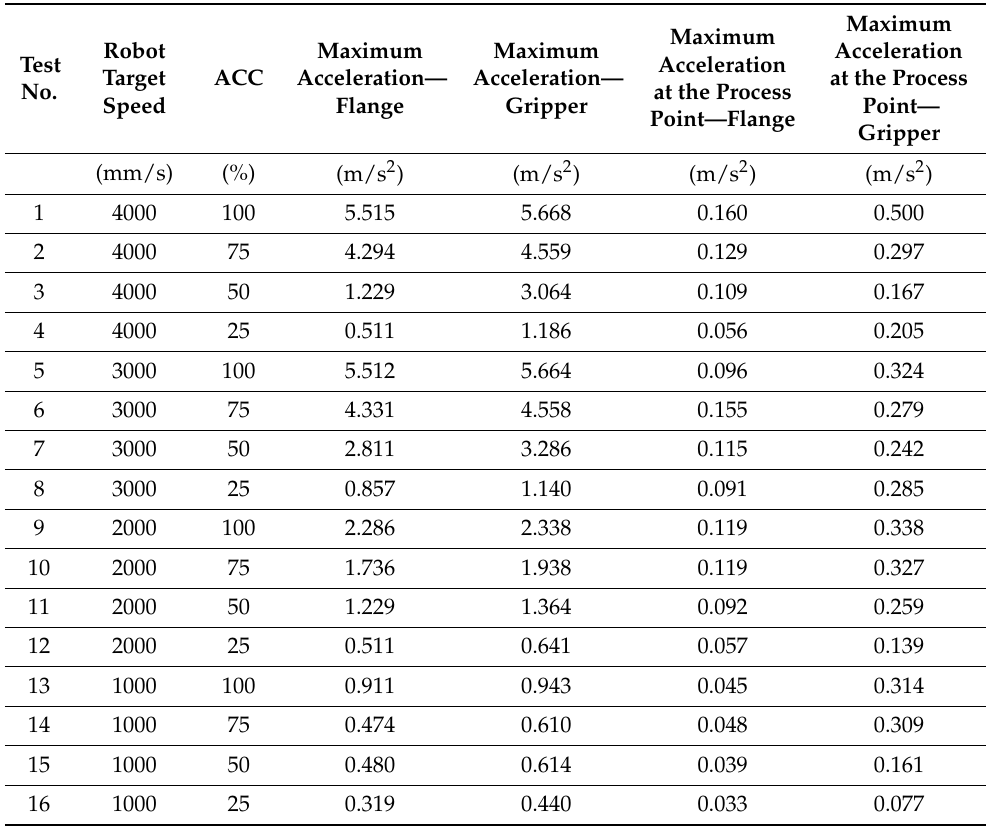
Figure 16. Graphs of accelerations obtained with MTi XSENS sensors mounted at the robot flange and on the gripper for parameters V4000 and ACC100. Table 2. Acceleration values measured by sensors mounted on the gripper.